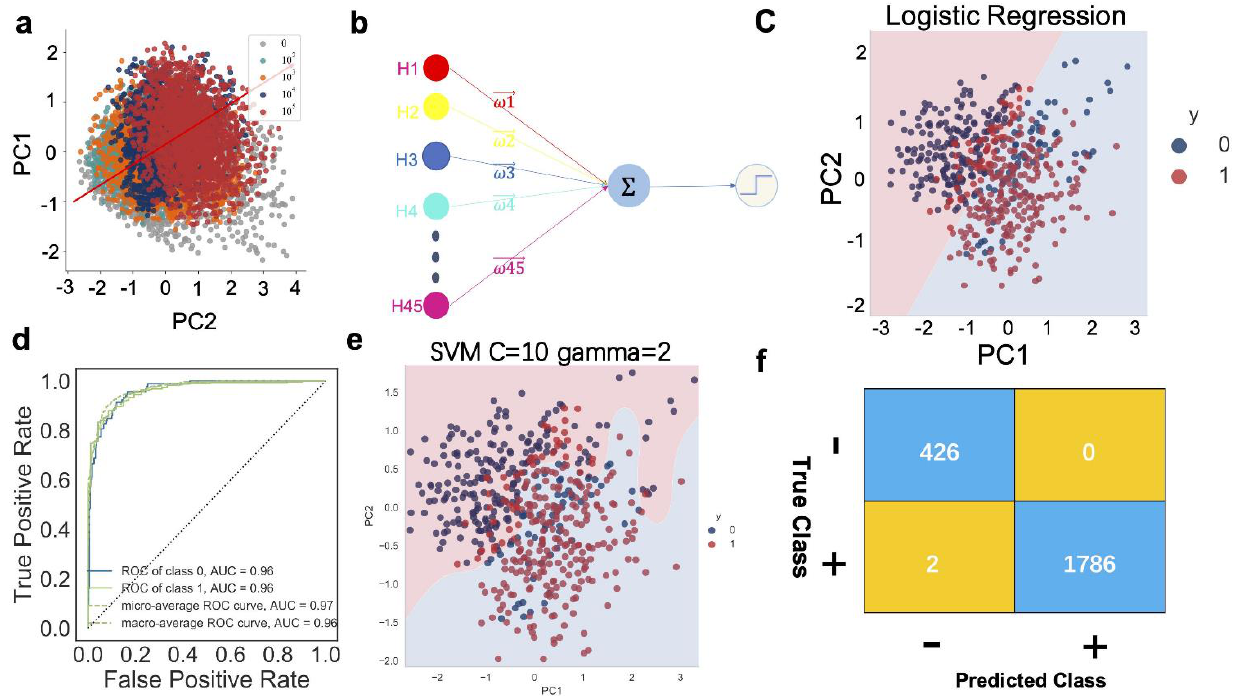
Figure 4. Accurate machine learning classifier models can be obtained from training multiple features. ( a ) Visualization of the variation in different SARS-CoV-2 concentrations by PCA. ( b ) The schematic of inputting the ratio values at different degrees of H in different SARS-CoV-2 concentrations into logistic regression model to predict whether it contains the SARS-CoV-2 virus. ( c ) A schematic diagram of the PC1 and PC2 in logistic regression model. The background color refers to the decision boundary of the classifier (0 refers to the chip image without SARS-CoV-2 virus, and 1 refers to with SARS-CoV-2 virus). ( d ) The ROC and AUC curve of logistic regression, AUC = 0.95, ROC virus positive of class. ( e ) A schematic diagram of the PC1 and PC2 in SVM classifier model. The background color refers to the decision boundary of the classifier (0 refers to the chip image SARS-CoV-2 virus negative, and 1 refers to SARS-CoV-2 virus positive, gamma = 2, C = 10). ( f ) Confusion matrix of SVM classifier (the + refers to virus positive chip image, the − refers to virus negative chip image).